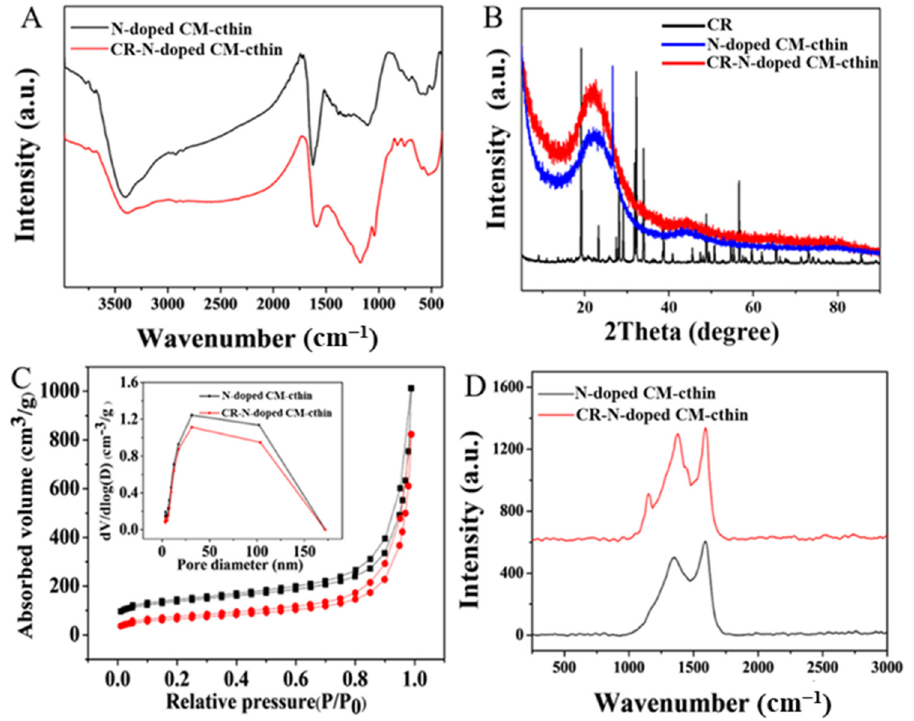
Figure 2. FT-IR spectra ( A ), XRD curves ( B ), Nitrogen adsorption-desorption isotherms ( C ), and Raman spectra ( D ) of N-doped CM-chitin before and after adsorption of CR.